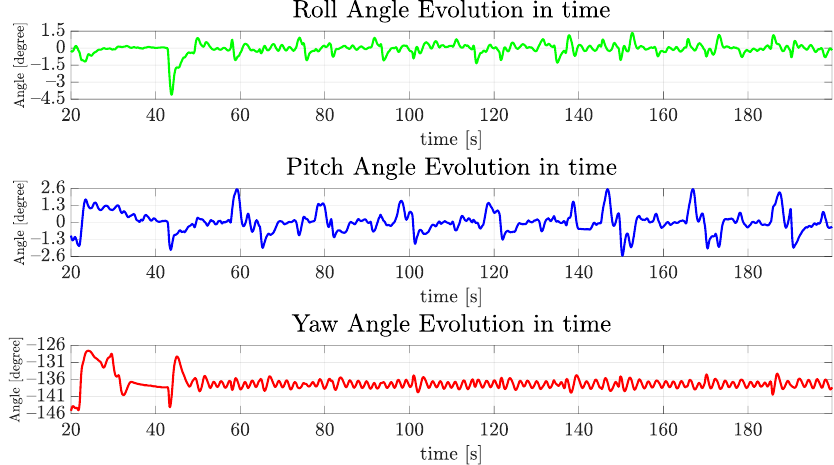
Figure 24. The evolution of orientation components of VITA1 over time for the real vehicle.